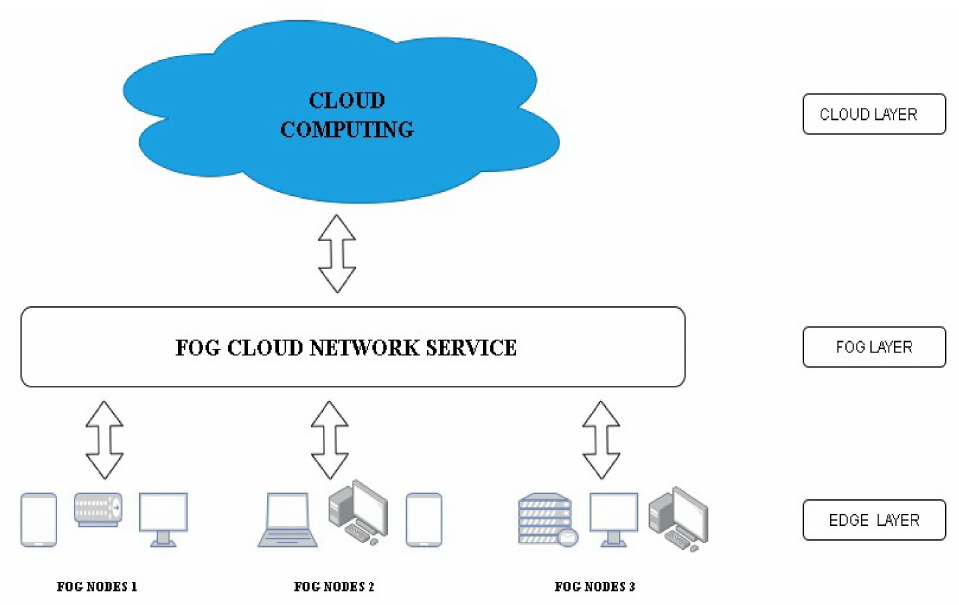
Figure 3. The architecture of the fog computing